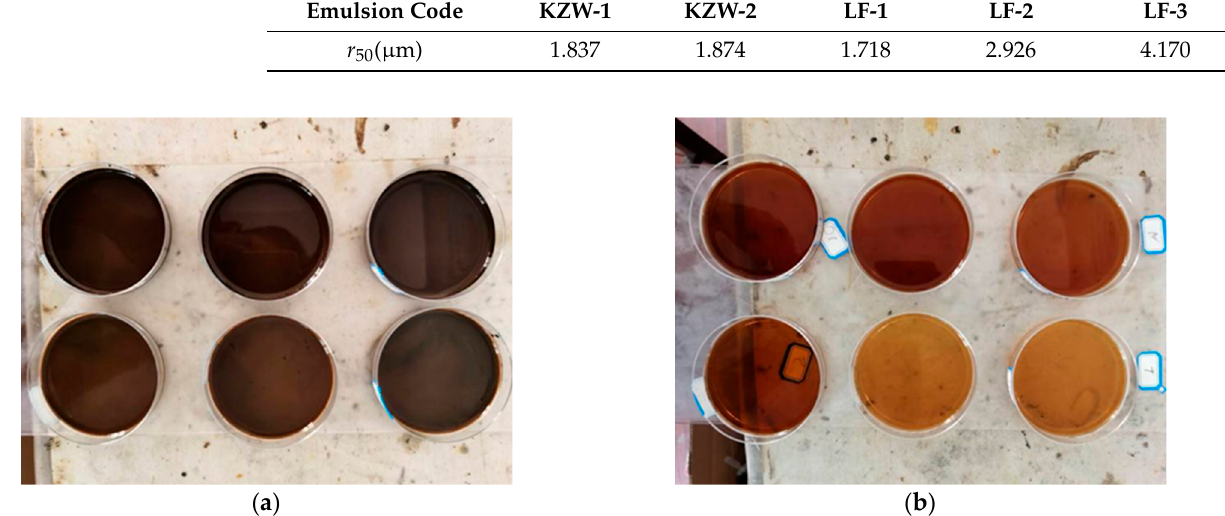
Figure 2. Drying test of asphalt emulsion and emulsifier solution, ( a ) Asphalt emulsion, ( b ) Emulsifier solution.